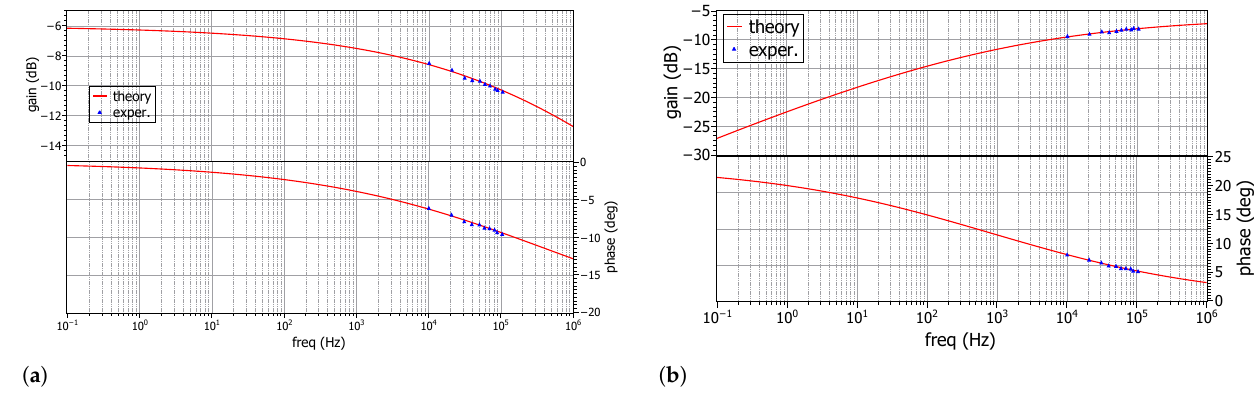
Figure 11. Frequency responses of filters of order 0.26, realized by ( a ) the topology in Figure 4a, and ( b ) the topology in Figure